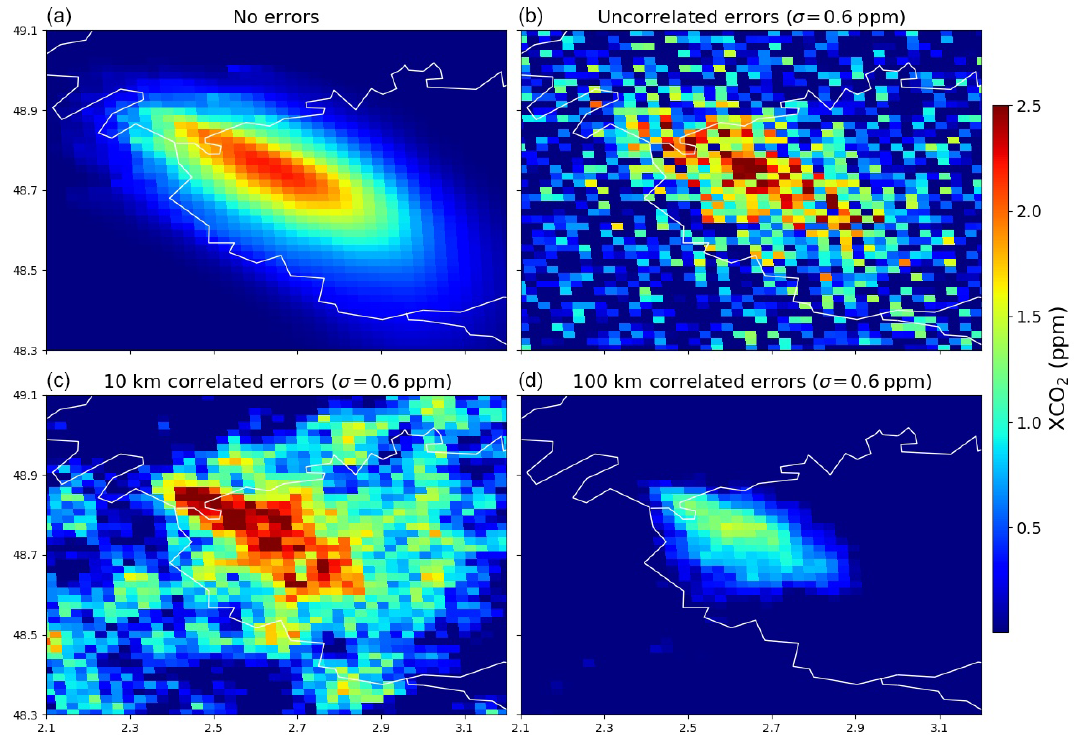
Figure A4. XCO 2 distributions produced by the emissions of the Paris area between 05:00 and 11:00LT on 8 March at 11:00LT: raw CHIMERE simulations (a) , raw CHIMERE simulations perturbed by an uncorrelated random noise of 0.6ppm (b) , and raw CHIMERE simulations perturbed by a multivariate normal distribution whose covariance matrix is characterized by an uncertainty of 0.6ppm for the diagonal terms and a correlation length scale of 10km (c) and of 100km (d)